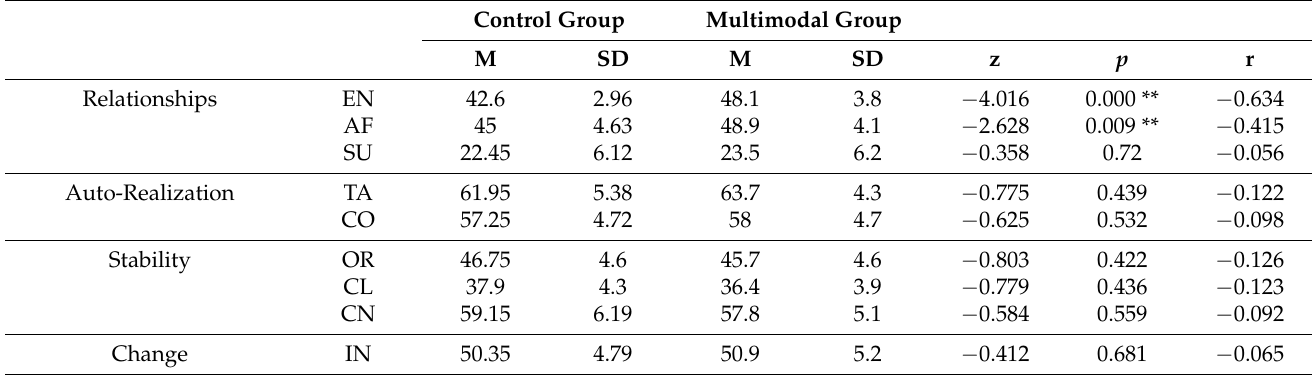
Table 8. Comparison between control and multimodal groups in the pre-test. School